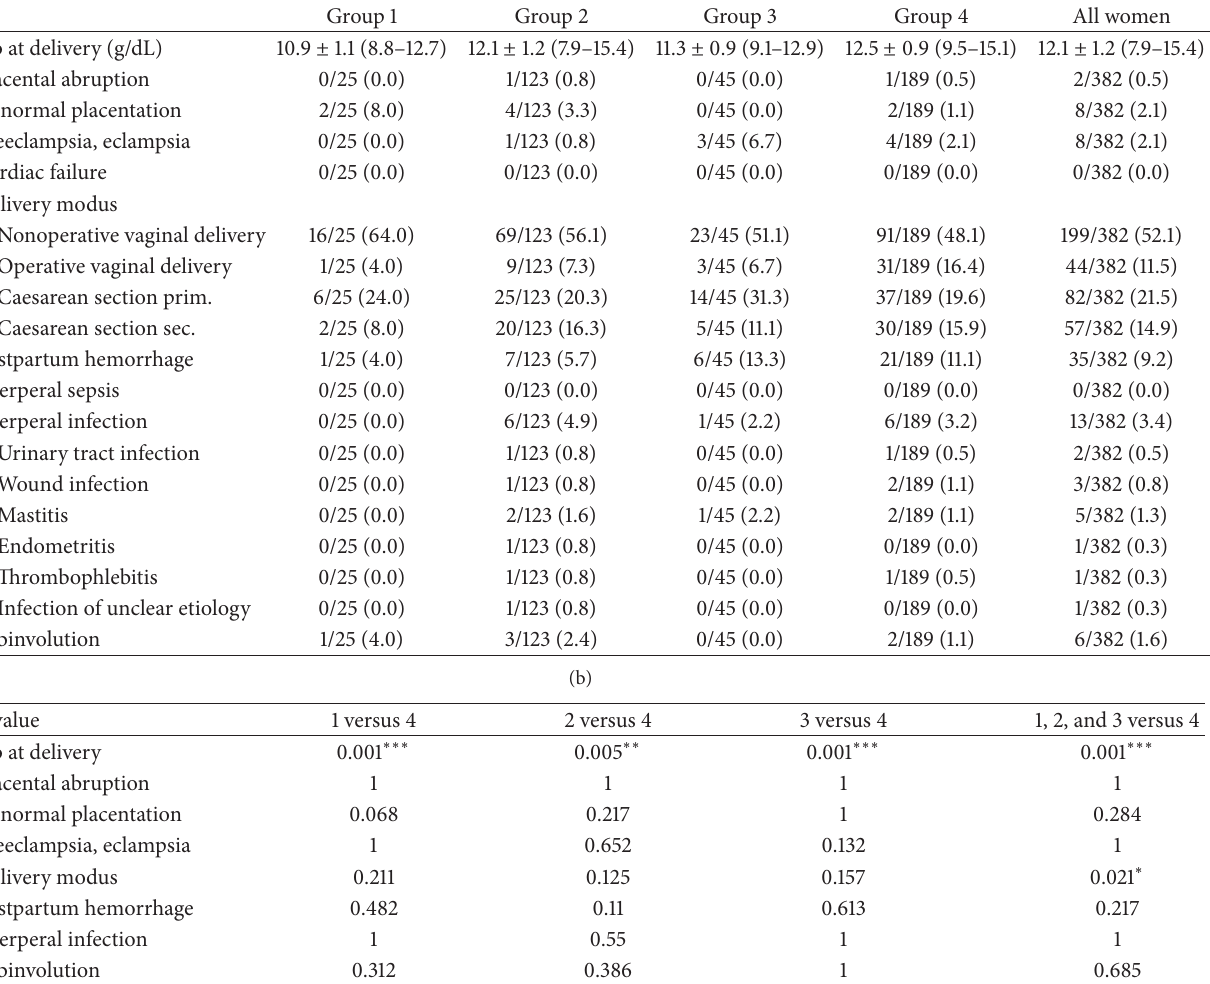
Table 2: Maternal outcome